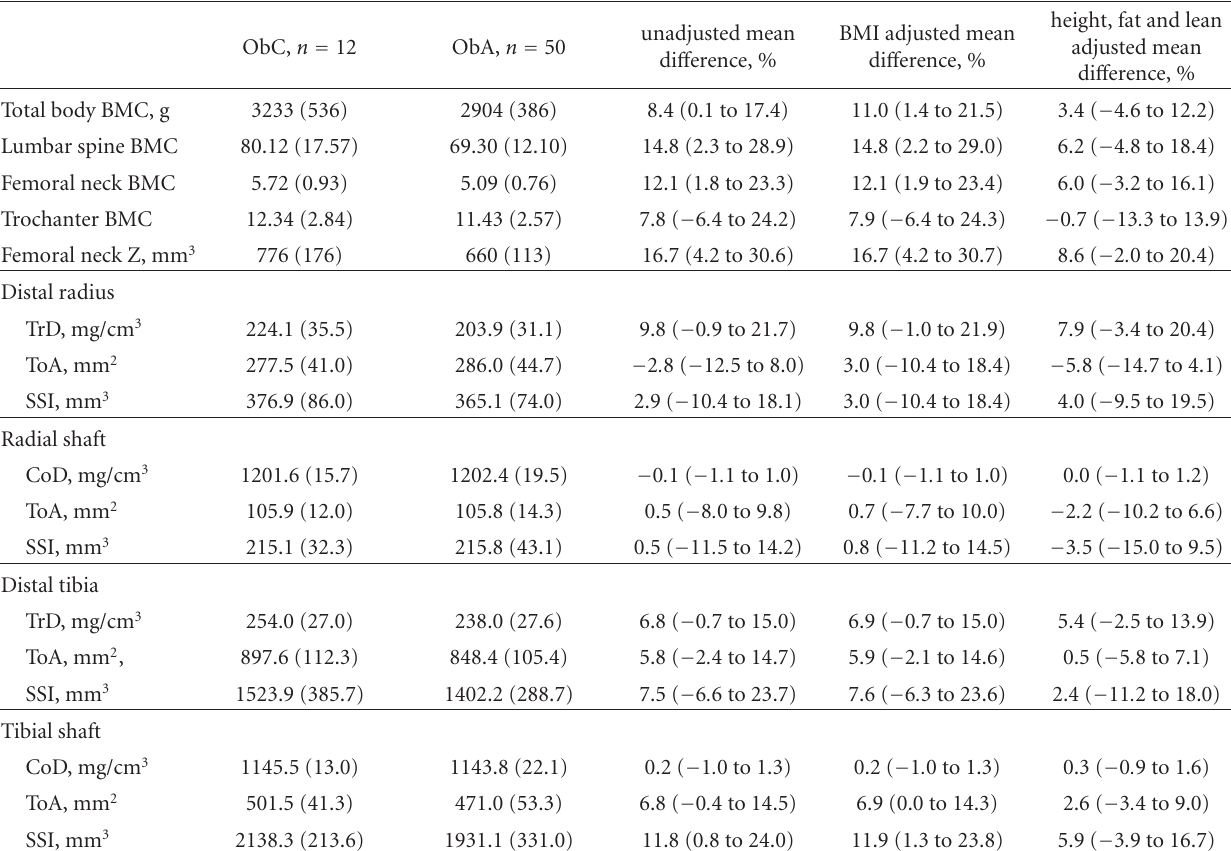
Table 2: Unadjusted bone values (SD), BMI-adjusted, and height, fat, and lean mass-adjusted between-group (ObC versus ObA) mean di ff erences (95%